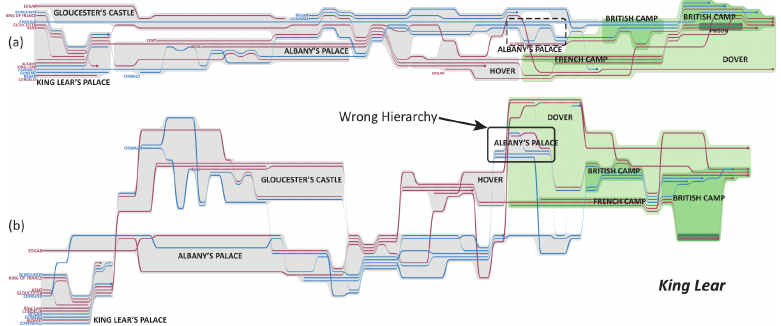
Figure 26. Comparison of King Lear using both methods of layout; ( a ) StoryFlow; ( b ) previous method by Tanahashi and Ma [48]. The StoryFlow layout presented in this paper focuses on minimising white space and efficiently ordering the story lines to ensure the most concise visual representation of a story. Intersecting lines represent interaction between characters and major events in the story are labeled to add clarity to the visualization [49]. Image courtesy of Liu et al.